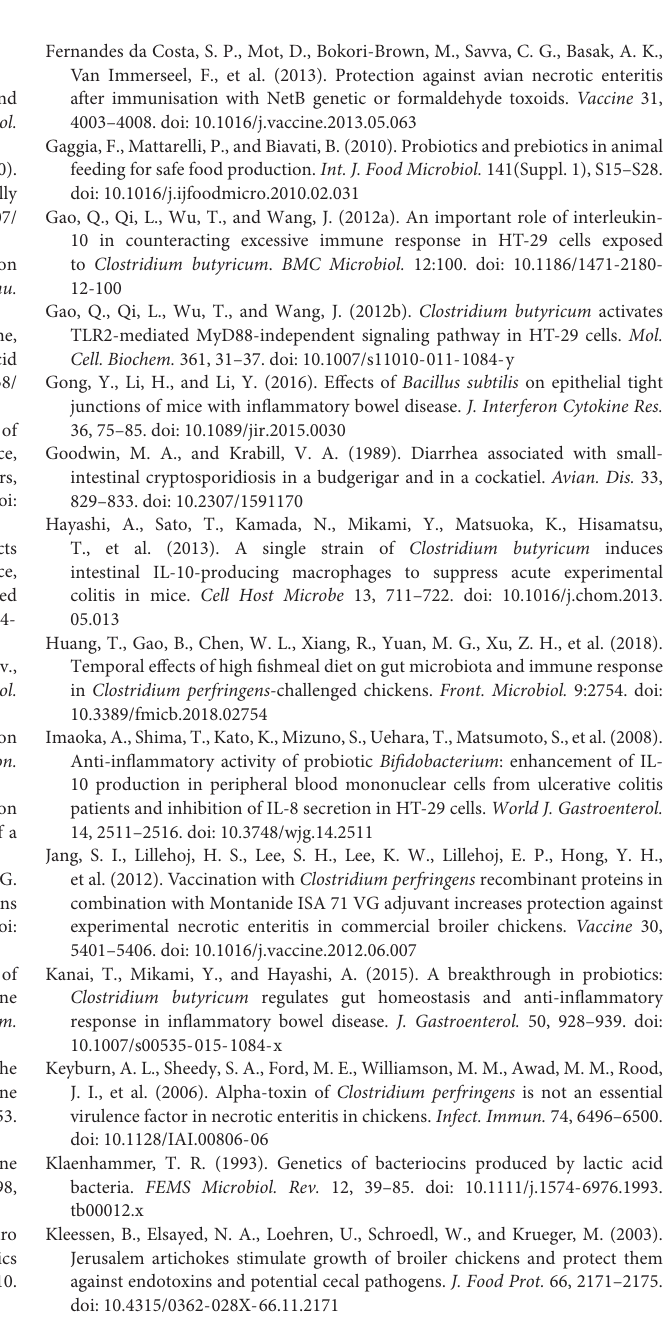
FIGURE S1 | Maximum-likelihood tree based on 16S rRNA gene sequences showing the phylogenetic relationships between strain C. butyricum YH 018 and closely related species of the genus Clostridium . The tree was constructed using the program MEGA 6 with bootstrap values based on 1000 replications. Filled